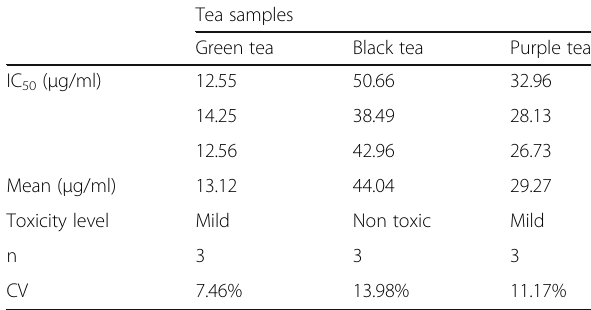
Table 1 Cytotoxicity of various tea extract Tea samples